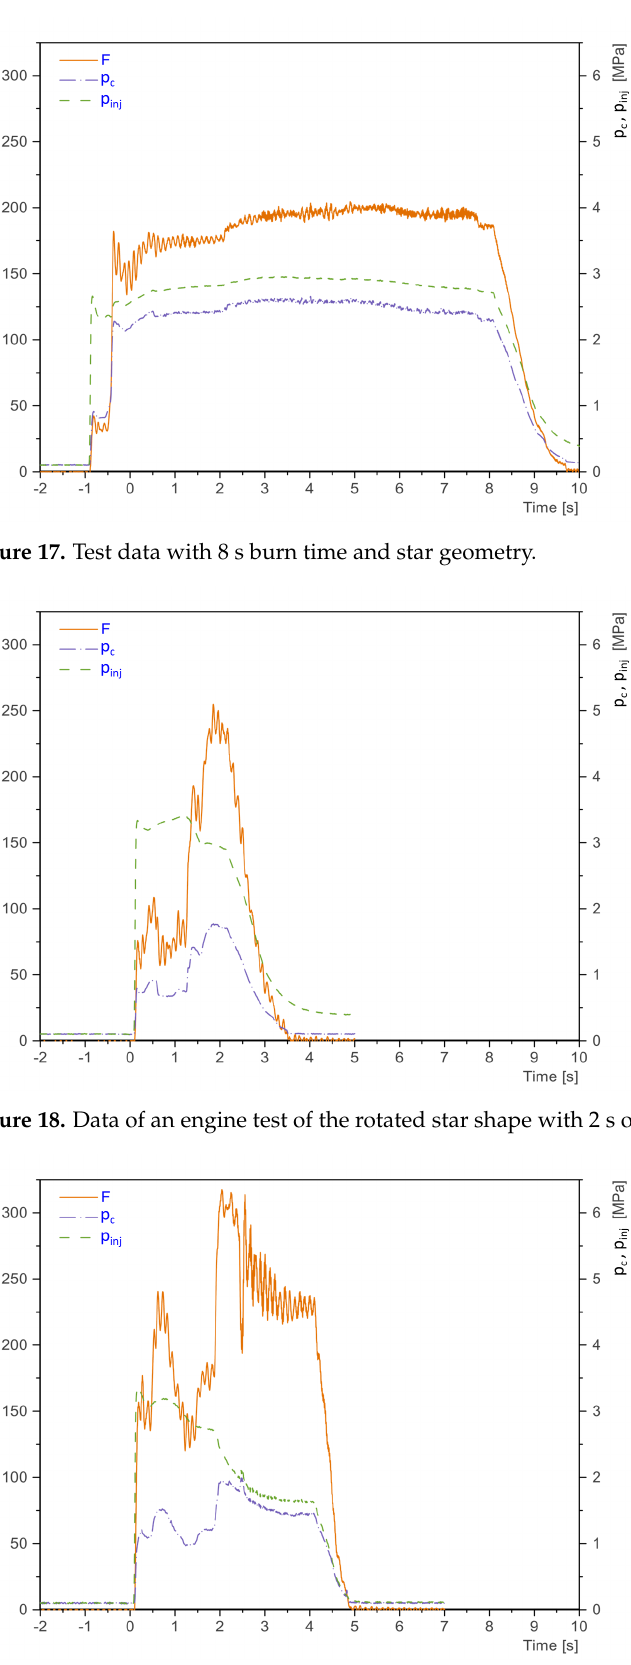
Figure 19. Test data of a rotated star geometry with 4 s burn